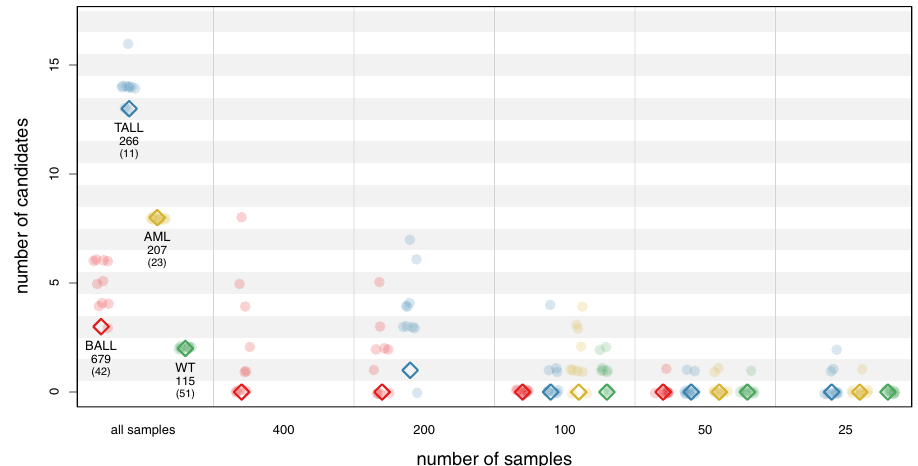
Fig. 4 Down-sampling the TARGET data set greatly reduces the number of candidates. Number of candidate pairs for the WeSME test on TARGET cancer types B-ALL, T-ALL, AML, and WT using either all samples, or down-sampled data sets. Dots represent the number of candidates for each of the ten replicates per sample size. Diamonds indicate the number of high con fi dent candidates (being a signi fi cant candidate in at least nine out of ten tests). The fi rst category (all samples) shows for each cancer type the original number of samples in the TARGET and -in parentheses- in the DKFZ data set. Source data underlying Fig. 4 can be found in Supplementary Data